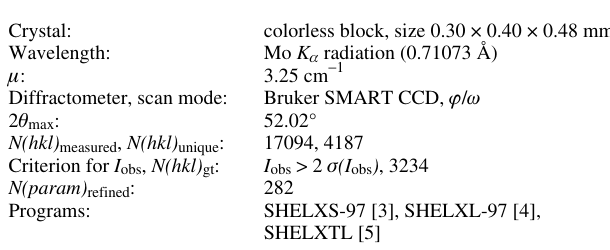
Table 1. Data collection and handling.